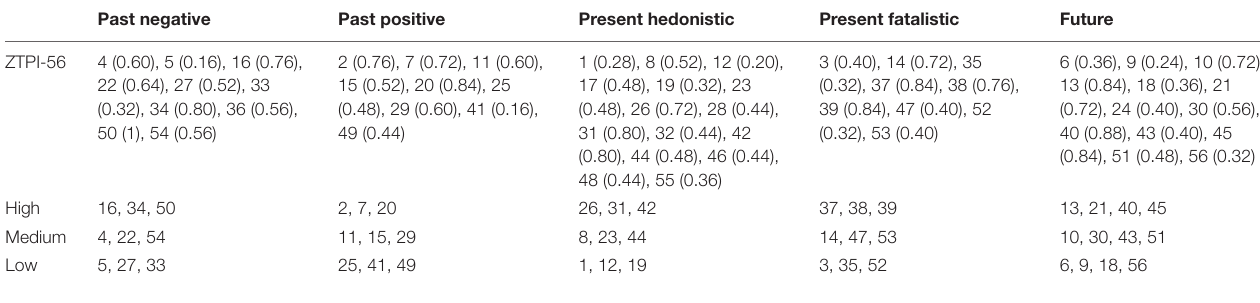
TABLE 1 | Frequency of each item of the ZTPI in 25 short versions and three short forms with high, medium, and low frequent items. Past negative Past positive Present